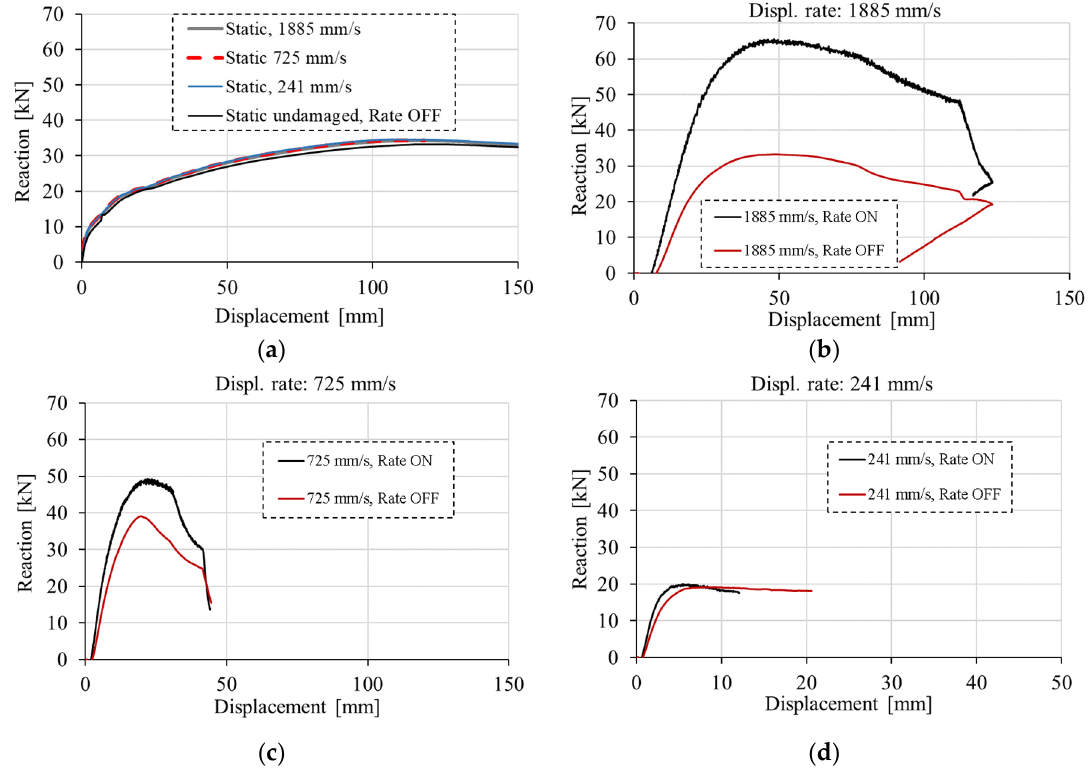
Figure 18. Reaction vs. displacement: ( a ) quasi-static and dynamic for initial loading rates: ( b ) 1885 mm / s, ( c ) 725 mm / s and ( d ) 241 mm / s.